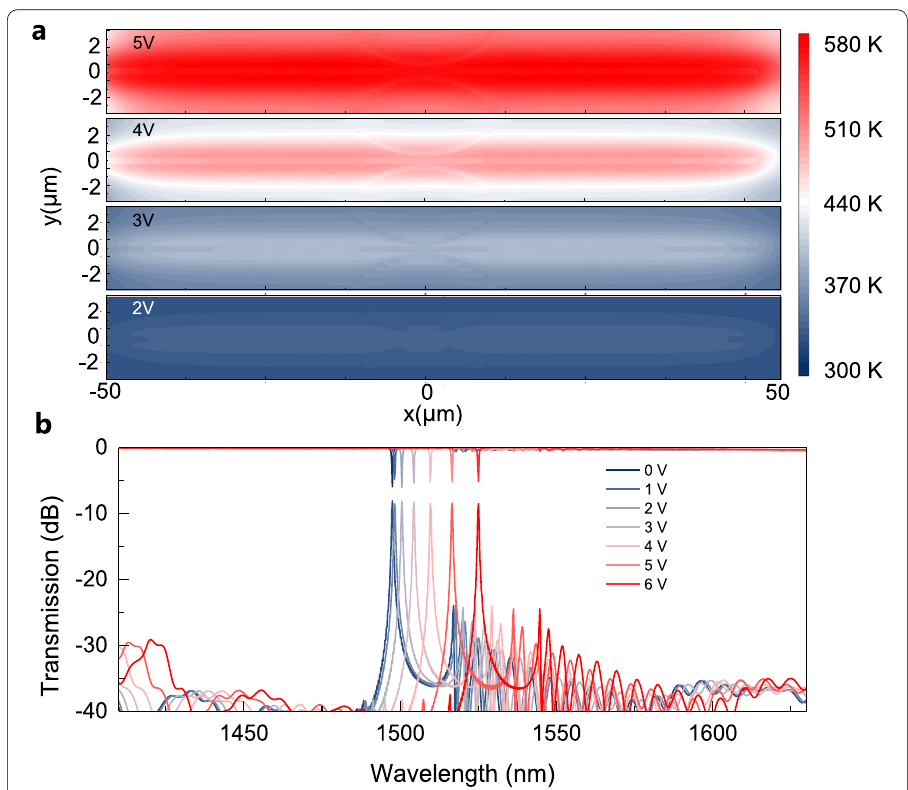
Fig. 4 Thermo-optic co-simulations of the filter. a Temperature distribution at different bias voltages based on a 3D simulation, sharing the same temperature color bar. b The optical response at D1 port by 3D FDTD